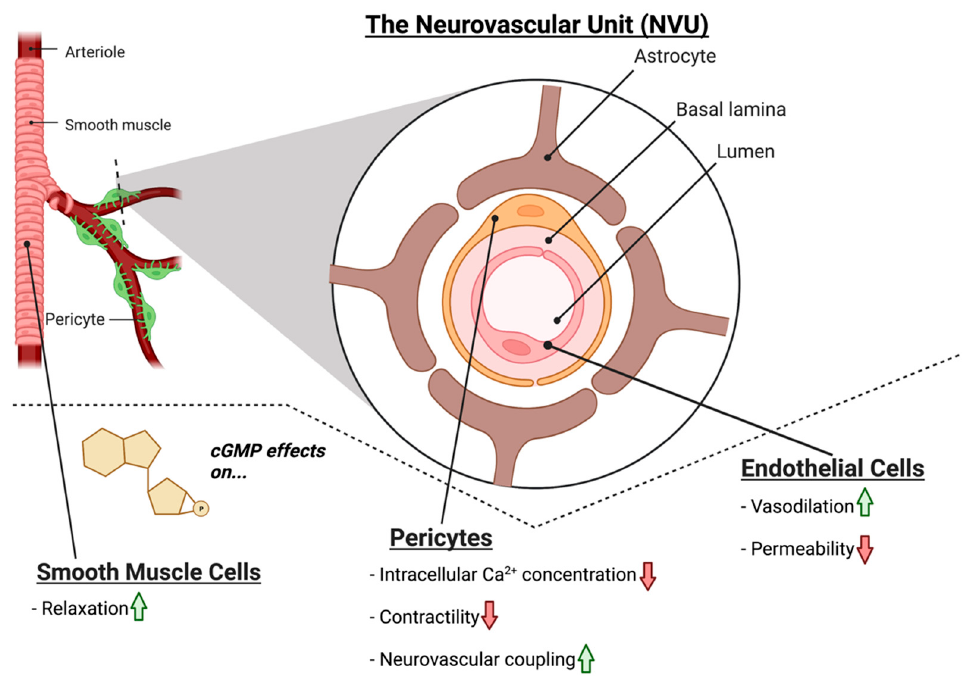
Figure 2. The effects of cGMP on vascular cells of the retinal NVU. cGMP increases smooth muscle cell relaxation. In pericytes, cGMP has been shown to reduce intracellular Ca 2+ , decrease contractility, and increase NVC mechanisms. In endothelial cells, cGMP has been shown to increase vasodilation, while reducing endothelial cell permeability.